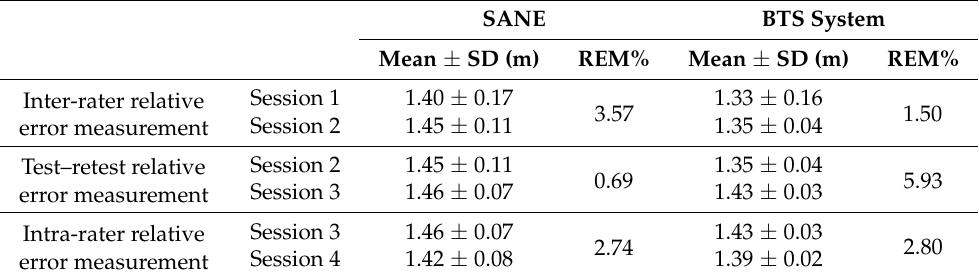
Table 7. Results for gait cycle length.